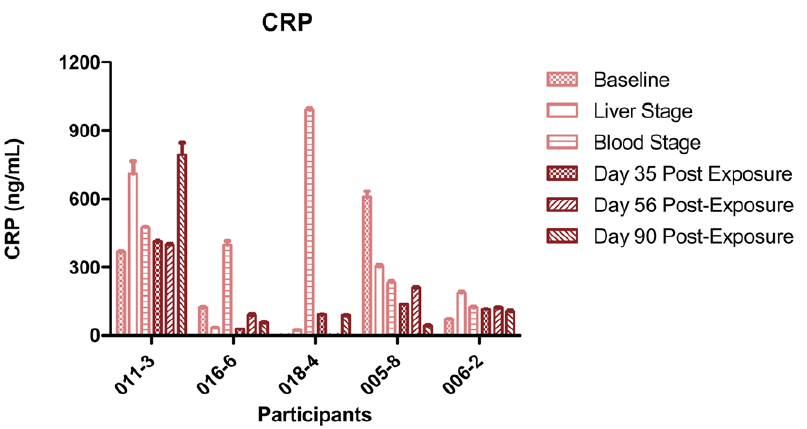
Figure 3. General inflammation in the periphery does not correlate to HIV production in co-cultures. Generalized immunological activation as assessed by C-Reactive Protein (CRP) levels in the plasma collected at the time of PBMC isolation in the five malaria challenge participants. CRP was detected by ELISA. The light pink bars correspond to the early visits (baseline, liver stage, time of first parasitemia) and the burgundy bars correspond to the three post-exposure time points (day 35, day 56, and day 90). The bars show the average CRP levels in the plasma at the time of PBMCs isolation for the 5 participants. Error bars represent the SEM for the triplicate wells run at each time point. Levels of CRP in the plasma did not increase at the post-exposure time points when the increase in HIV production was observed, suggesting that the increase in HIV production was specific to malaria antigen re-exposure and not a result of generalized immune activation.